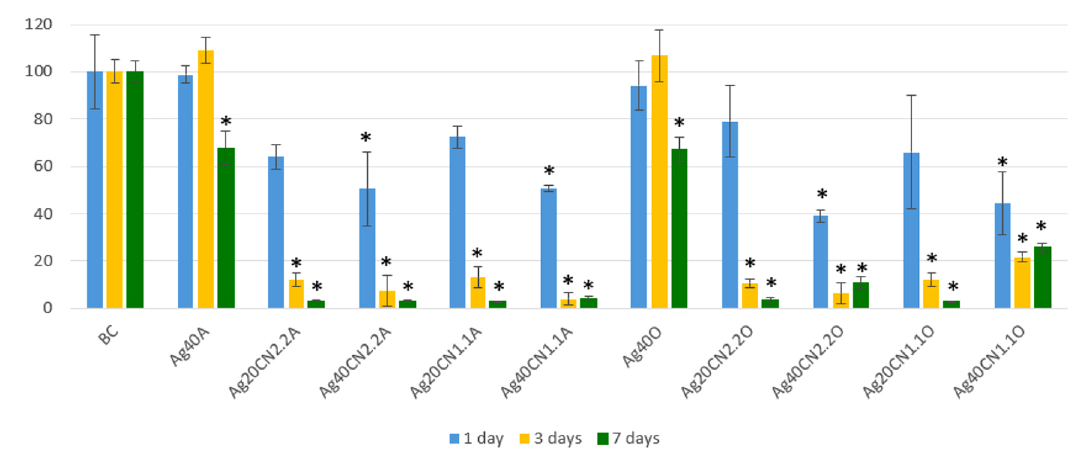
Figure 13. Graph of % of cell viability over time for the samples thermally treated in the oven and in the autoclave. *significant differences with respect to the BC group (control) on the respective days of exposure (or